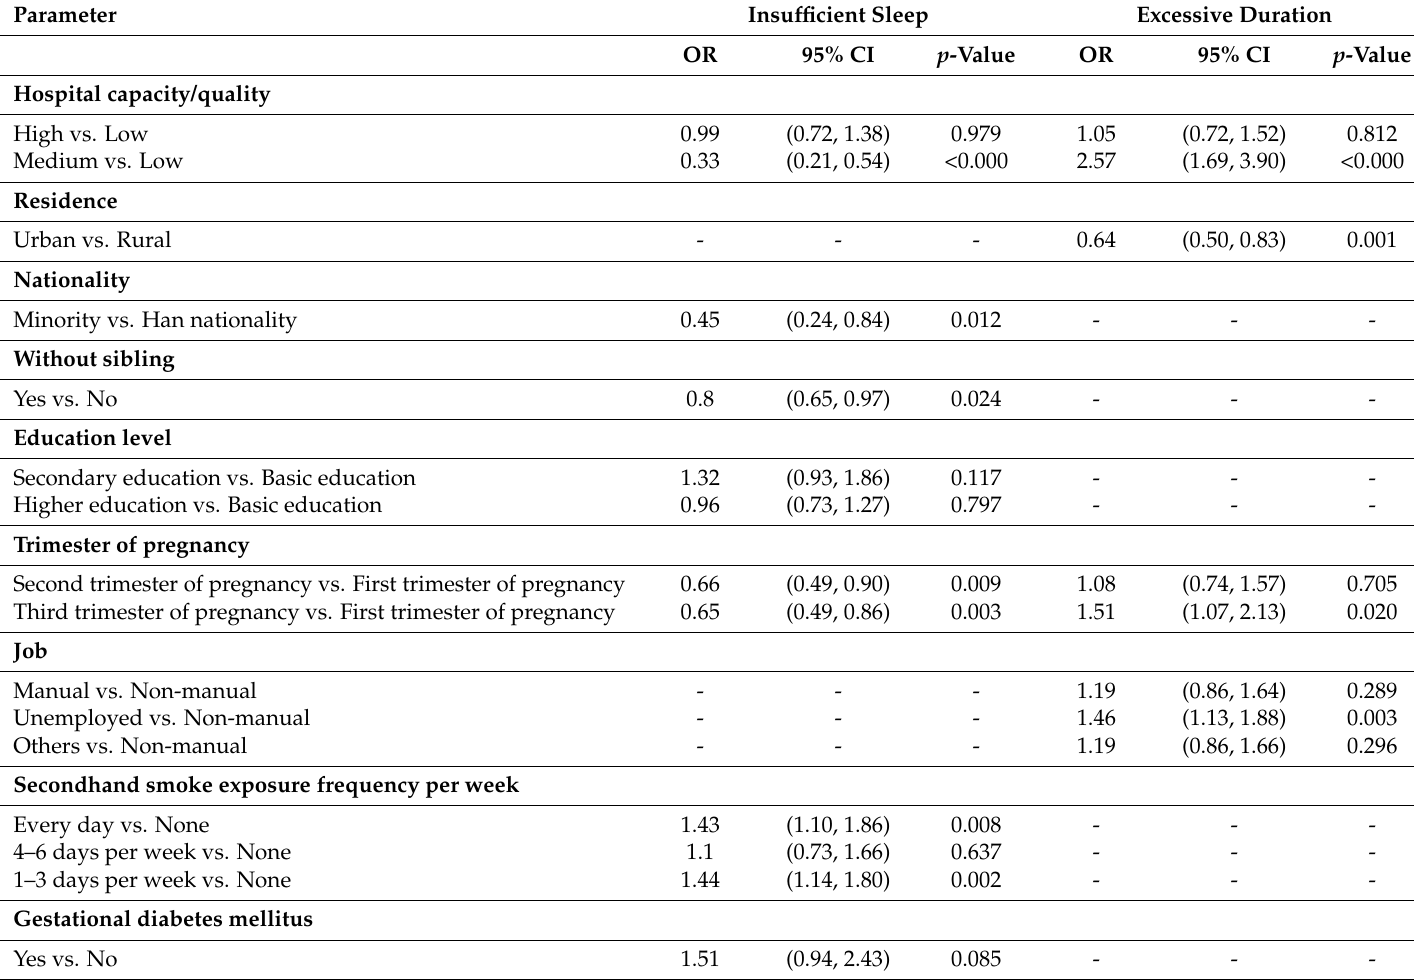
Table 2. Odds ratio (OR) (95% confidence interval (CI)) for factors influencing insufficient and excessive sleep in 2015.